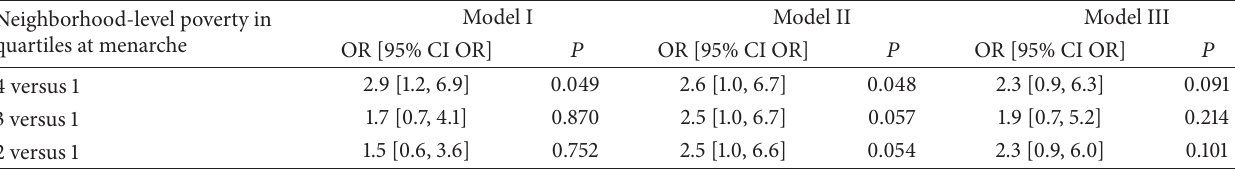
Table 2: Association of neighborhood-level poverty (in quartiles) at menarche with body mass index category. Neighborhood-level poverty